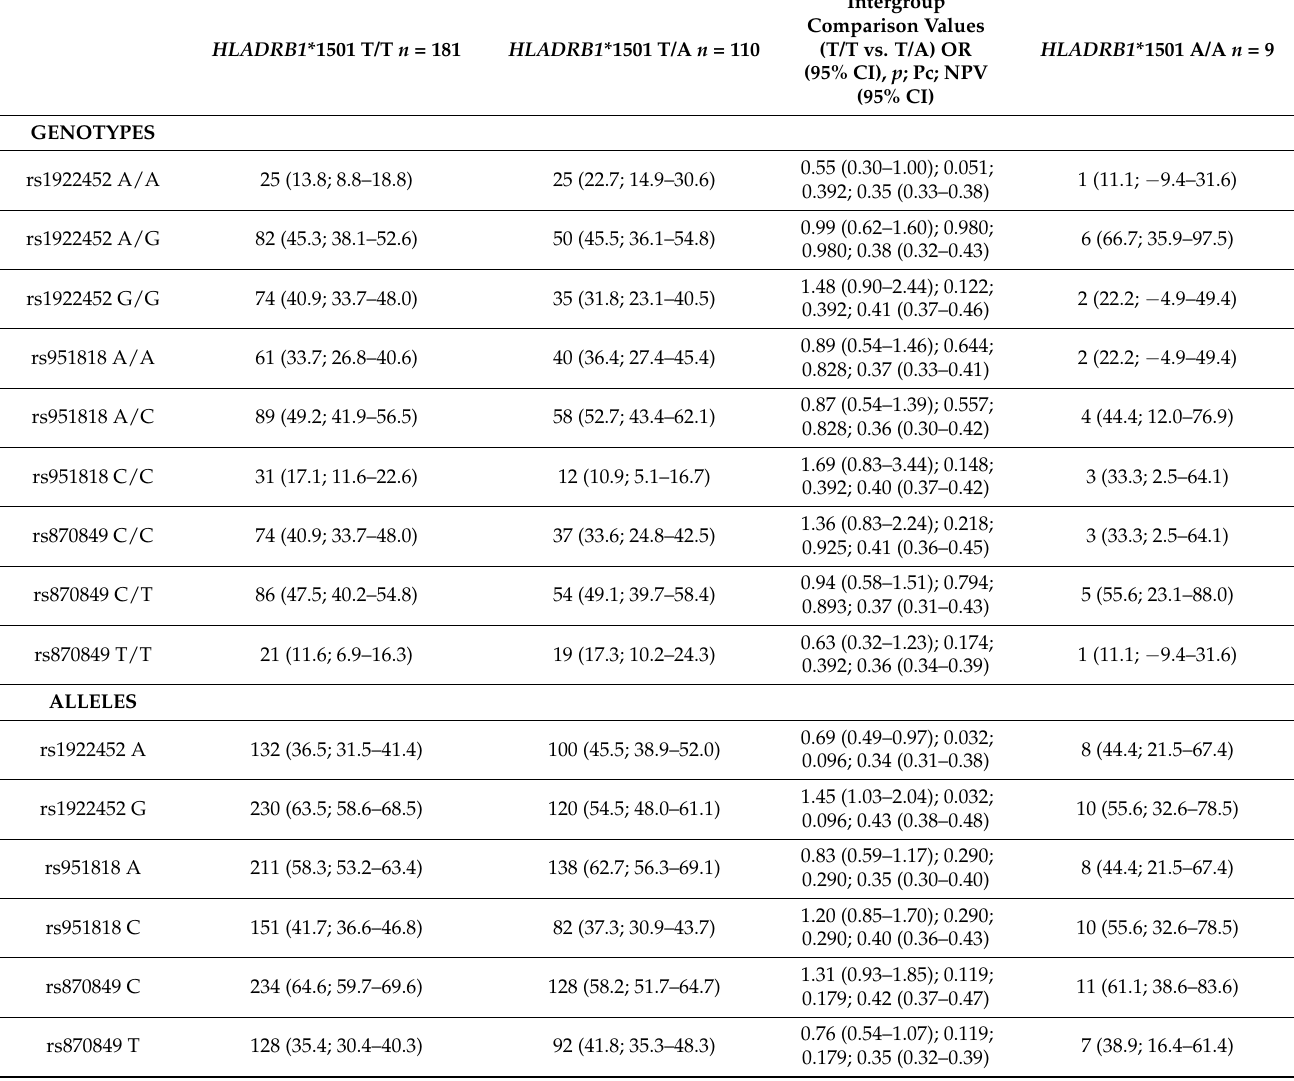
Table 6. Genotypes and allelic variants of patients with MS distributed by HLADRB1*1501 (rs3135388) genotype. The values in each cell represent the number (percentage; 95% confidence